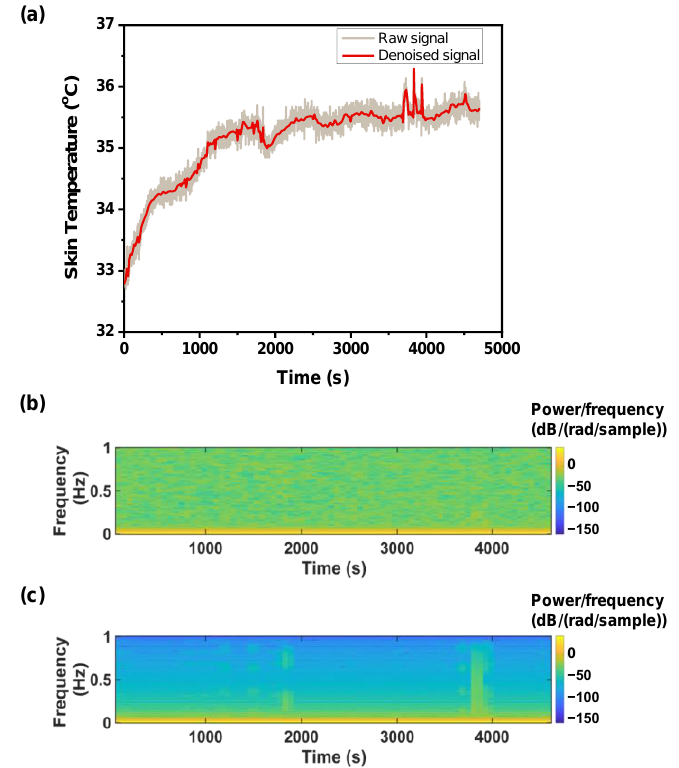
Figure 5. Extracting skin temperature: ( a ) recorded skin temperature with noise reduction, ( b ) spec- trogram for recorded skin temperature, and ( c ) spectrogram for the denoised skin temperature. Table 3. Pseudo-code for wavelet-based feature creation. Algorithm To Construct Features Vector